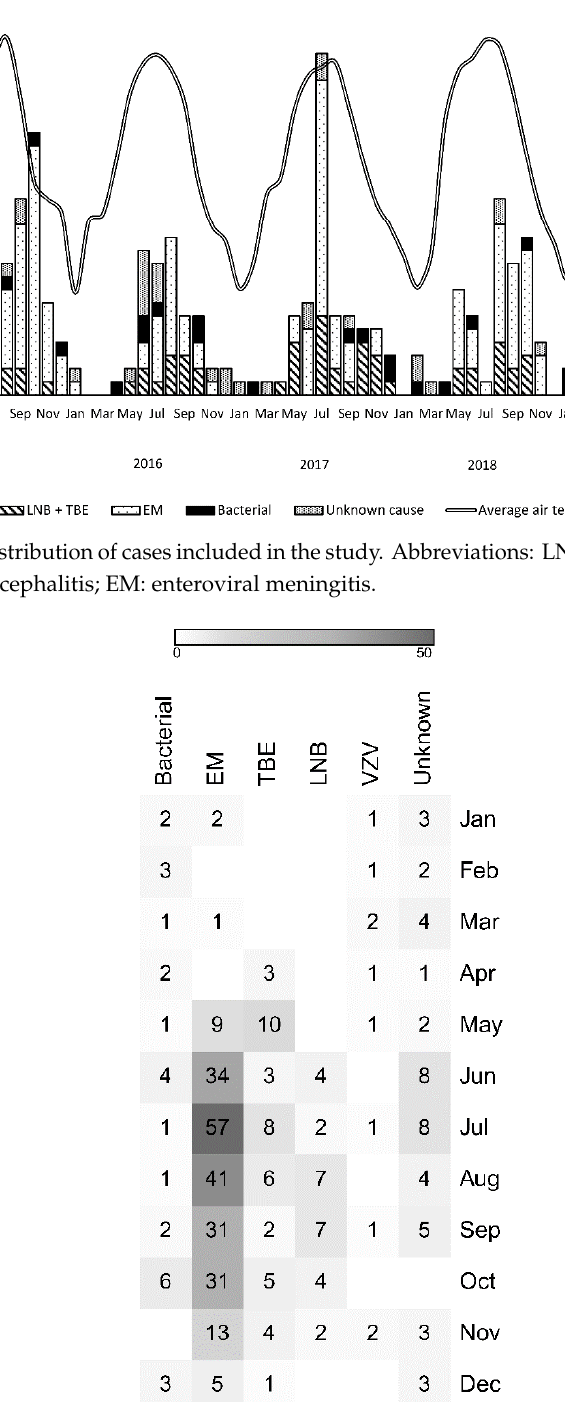
Figure 3. Monthly distribution of cases included in the study shown as a heat map. Abbreviations: LNB: Lyme neuroborreliosis; TBE: tick-borne encephalitis; EM: enteroviral meningitis; VZV: varicella zoster virus.